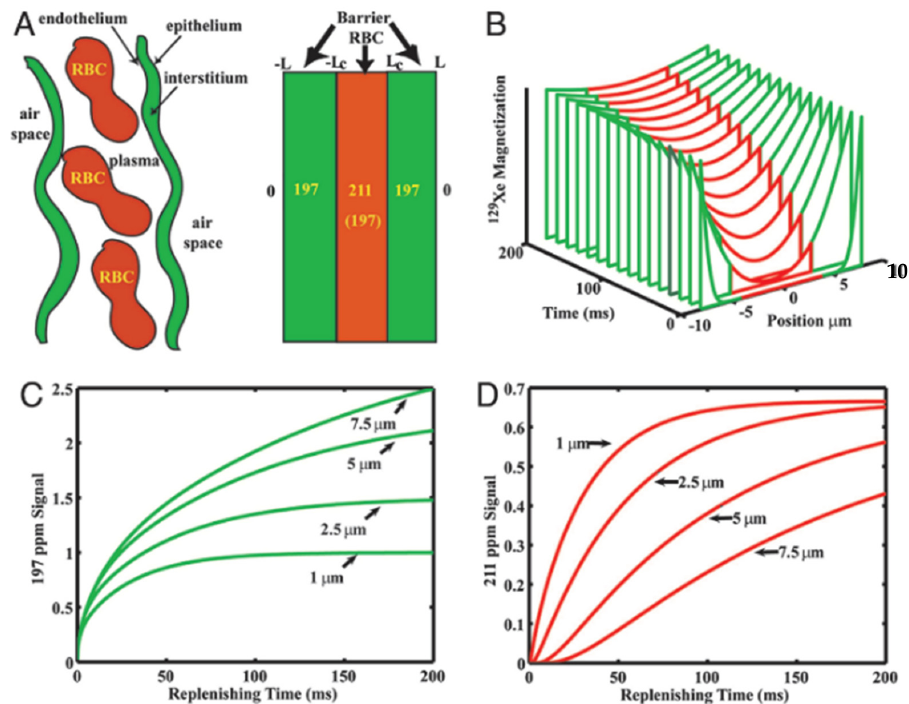
Figure 18. A simple model of alveolar wall structure ( A ) allows calculation of the expected diffusion dynamics ( B ) and the consequent temporal dynamics of the individual compartment peaks. Selection of the parameters that best describe observed behavior allows reframing in terms of microstructural dimensions of interest ( C , D ). Reprinted with permission from Driehuys, et al. ( Proc Natl Acad Sci USA 2006, ref.